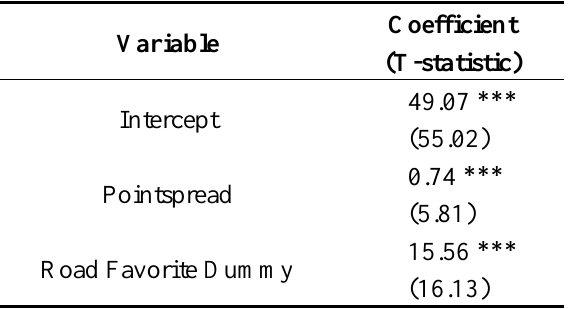
Table 5. Regression Results—Determinants of Favorite Betting Percentage—WNBA. Dependent Variable: Percentage Bet on Favorite.